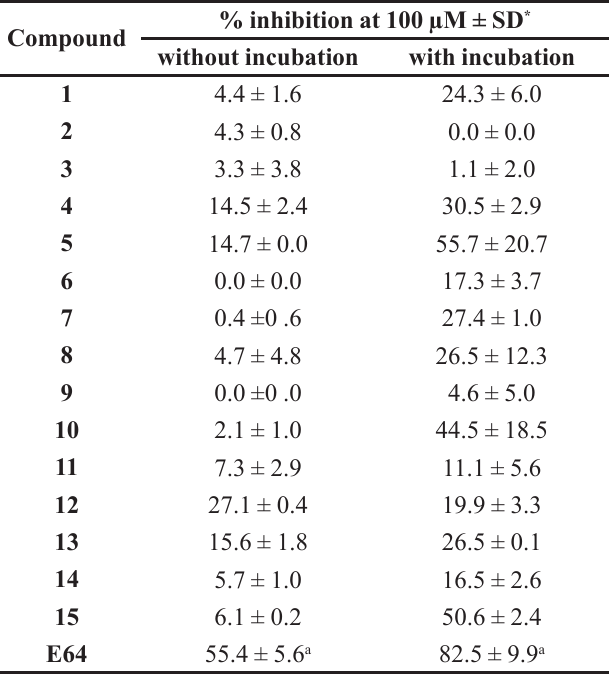
TABLE III – Inhibitory activity of 1 - 15 against SmCB1